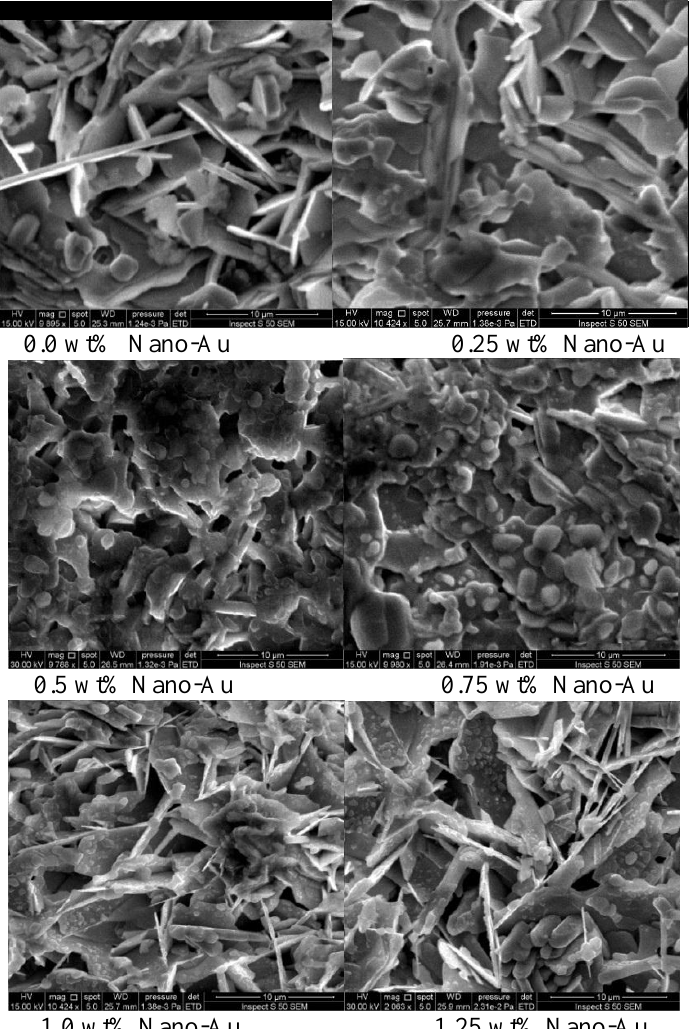
Fig. 2: SEM surface micrographs of (Au) -